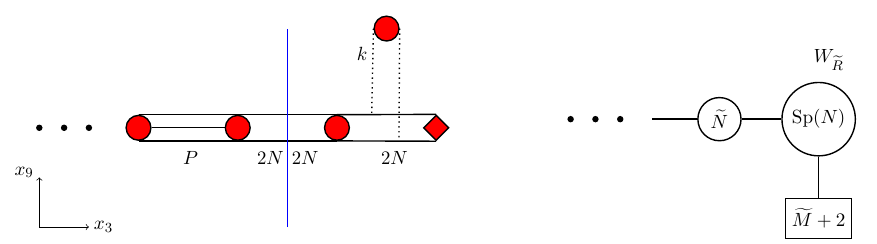
Figure 59 . S-dual of the Type IIB configuration in figure 57. The red rhombus denotes an O5 0 -plane. The associated quiver with the Wilson defect is shown on the right.